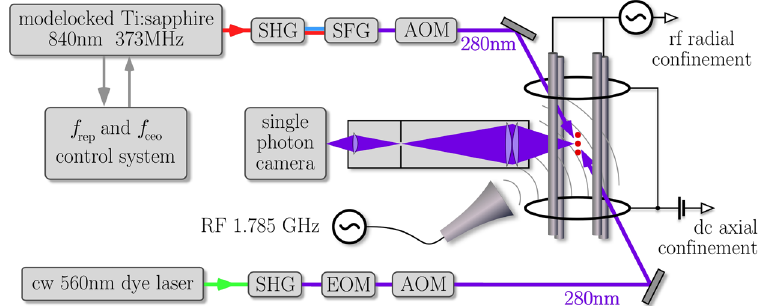
Figure 4. Schematic of the experimental setup. SHG: second-harmonic generation stage, SFG: sum-frequency generation stage, EOM: electro-optic modulator, AOM: acousto-optic